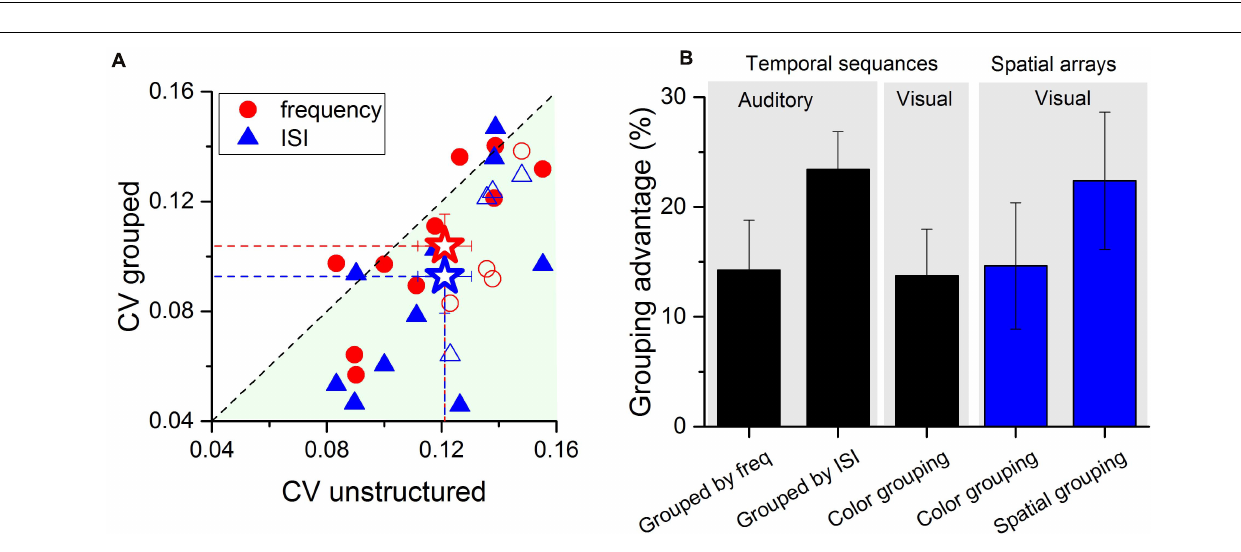
FIGURE 4 | Individual coefficients of variation for the three conditions. (A) Scatter plot of Coefficient of variation (CV) in the grouped conditions (red circles: stimuli grouped by frequency, blue triangles: stimuli grouped by ISI) plotted against those measured in the unstructured condition. For the grouping by ISI, the average CV was 0.09 (blue star and dashed line), for the grouping by frequency was 0.10 (red star and dashed line), both lower than the average CV in the unstructured condition (0.12). For almost all participants (naïve filled circles and triangles, authors open circles and triangles) CVs for grouped stimuli were lower than those for unstructured stimuli. Error bars are ± 1 SEM. (B) Groupitizing advantage on sensory precision across stimuli formats and sensory modalities. The first two bars report the grouping advantage for auditory stimuli (current study) grouped by frequency or by ISI (compared with unstructured stimuli). The other data show